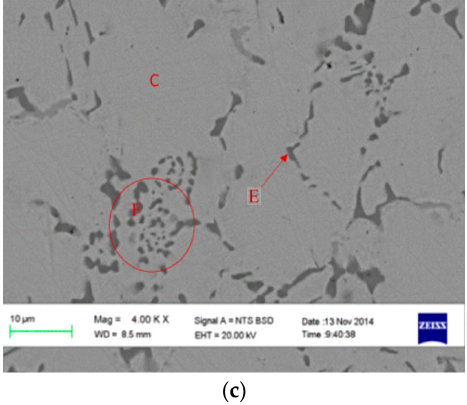
Figure 2. SEM BSE micrographs of ( a ) the as-cast, ( b ) annealed, and ( c ) quenched Ti 34 V 40 Cr 24 Fe 2 .